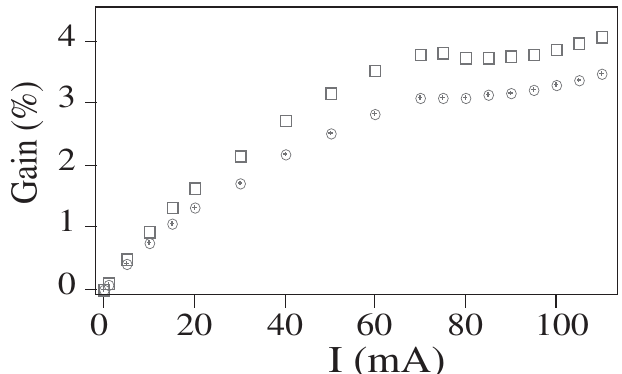
FIG. 5. (Color) Gain versus current in the achromatic ( (cid:10) ) and chromatic ( (cid:1) ) cases. Assumed coupling between the x and z (cid:6) 616 (cid:9) m , (cid:2) (cid:6) 103 (cid:9) m in the achro- dimensions: 10% ( (cid:2) x z (cid:6) 500 (cid:9) m , (cid:2) (cid:6) 70 (cid:9) m in the matic case, and (cid:2) x z